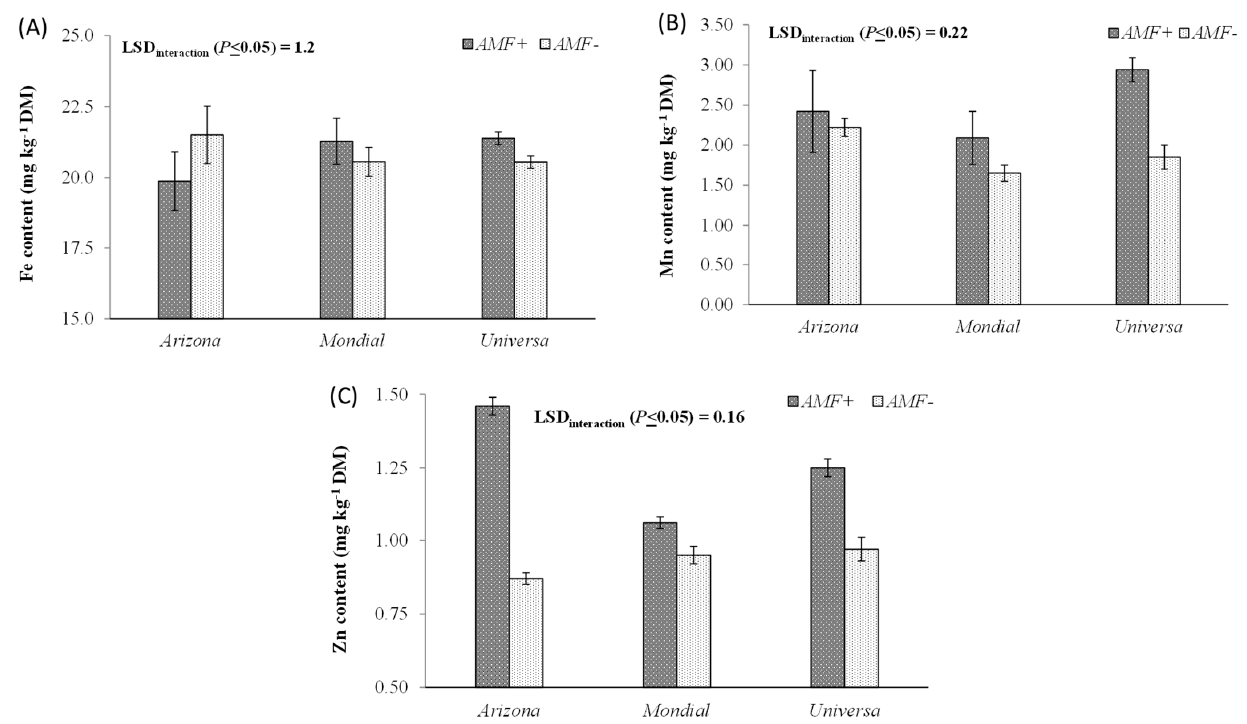
Figure 2. Effect of “soil mycorrhization × cultivar” interaction on the tuber levels of Fe ( A ), Mn ( B ), and Zn ( C ). Data are presented as mean ± standard deviation. AMF+: mycorrhizal inoculated plots; AMF ‐ : non ‐ mycorrhizal inoculated plots.